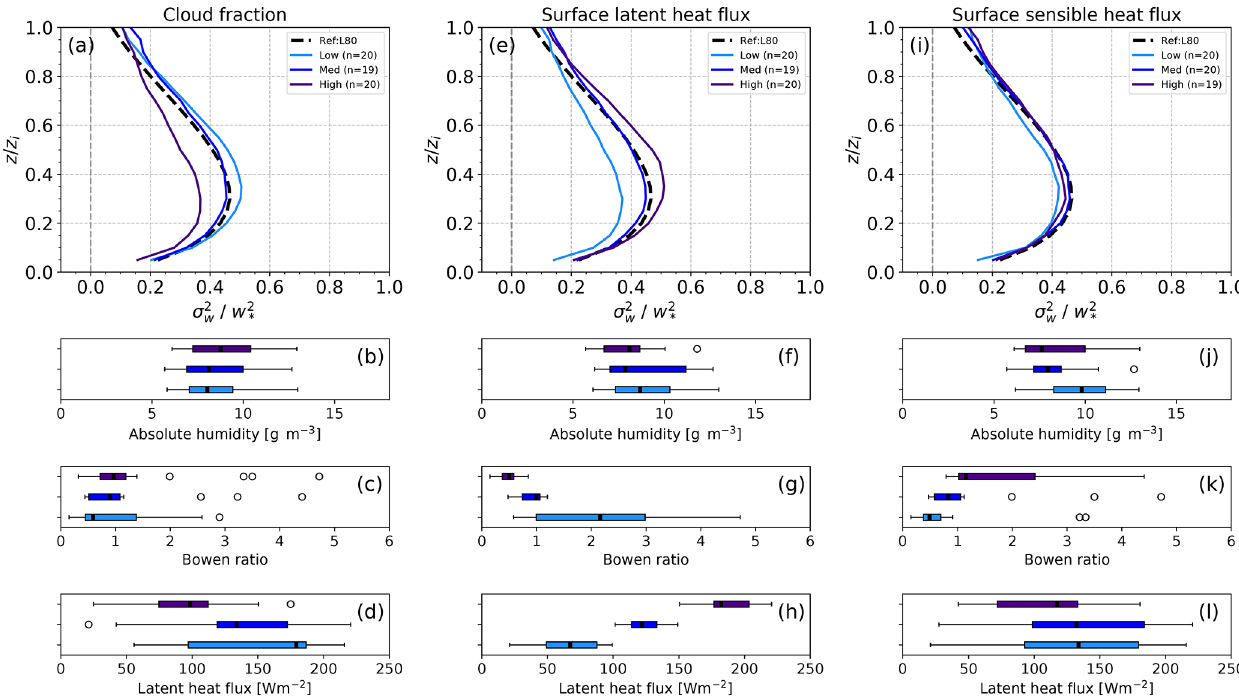
Figure 11. Vertical profiles of σ 2 w /w 2 ∗ averaged based on different classifications: (a) cloud fraction, (e) surface latent heat flux and (i) surface sensible heat flux. In the box plots, the corresponding values of relative humidity (b, f, j) , Bowen ratio (c, g, k) and surface latent heat flux (d, h, l) for each classification are shown. The number of days ( n ) in each category are added in the legend.